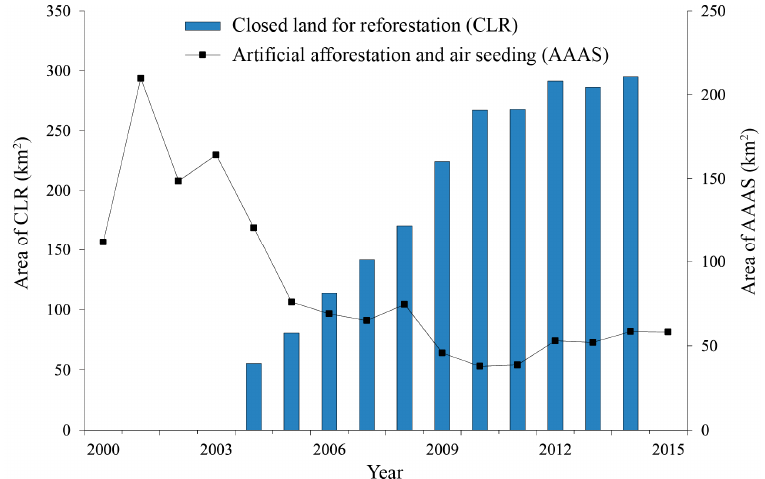
Figure 10. The area of closed land for reforestation (CLR) and the area of annual artificial afforestation and air seeding (AAAS) in Ordos.